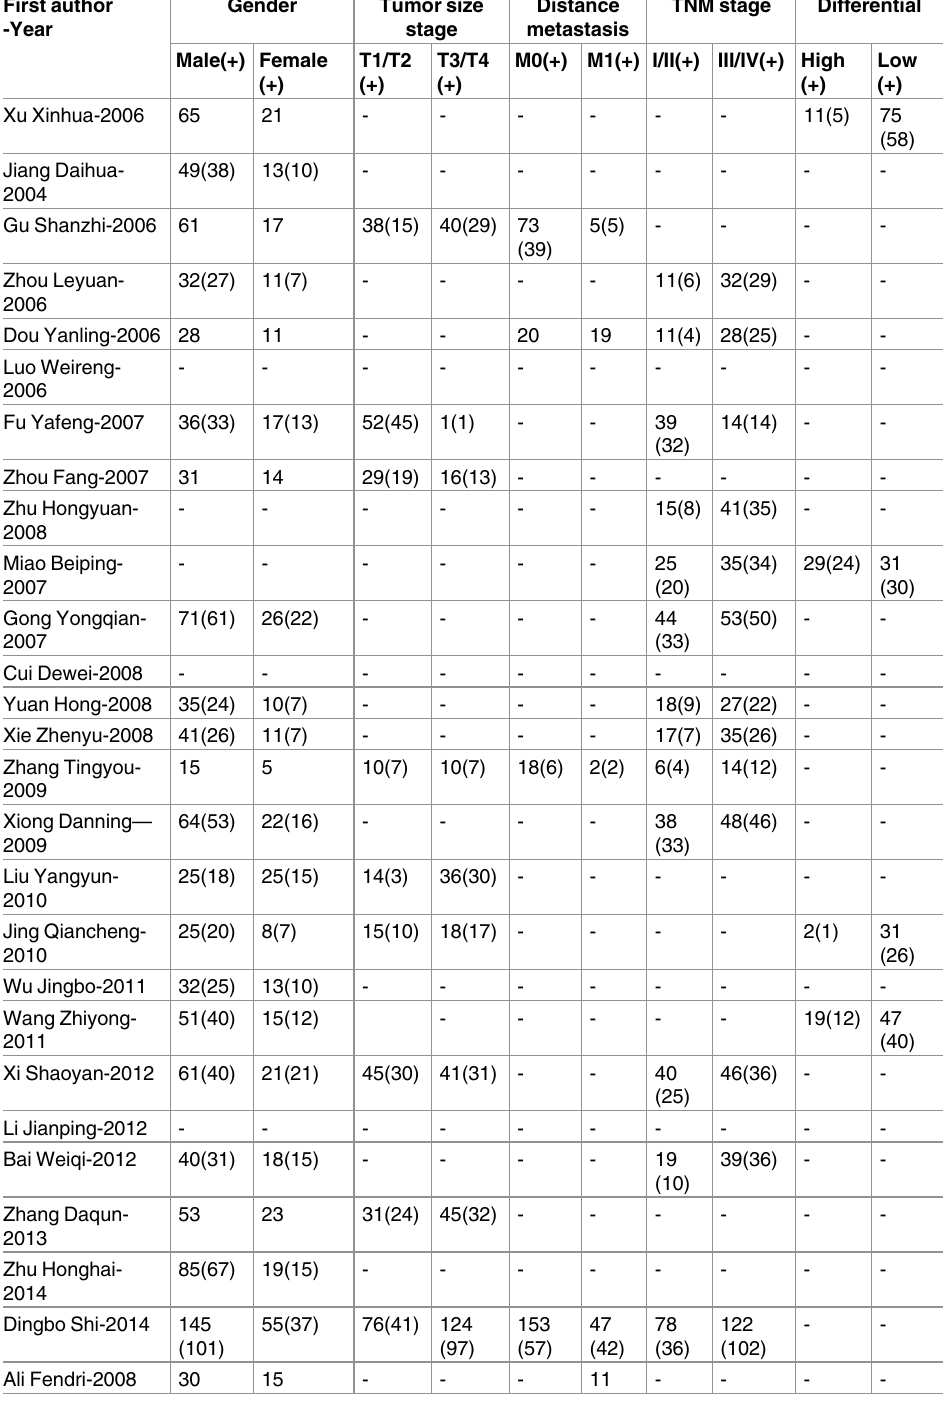
Table 2. Other clinical characteristics of included